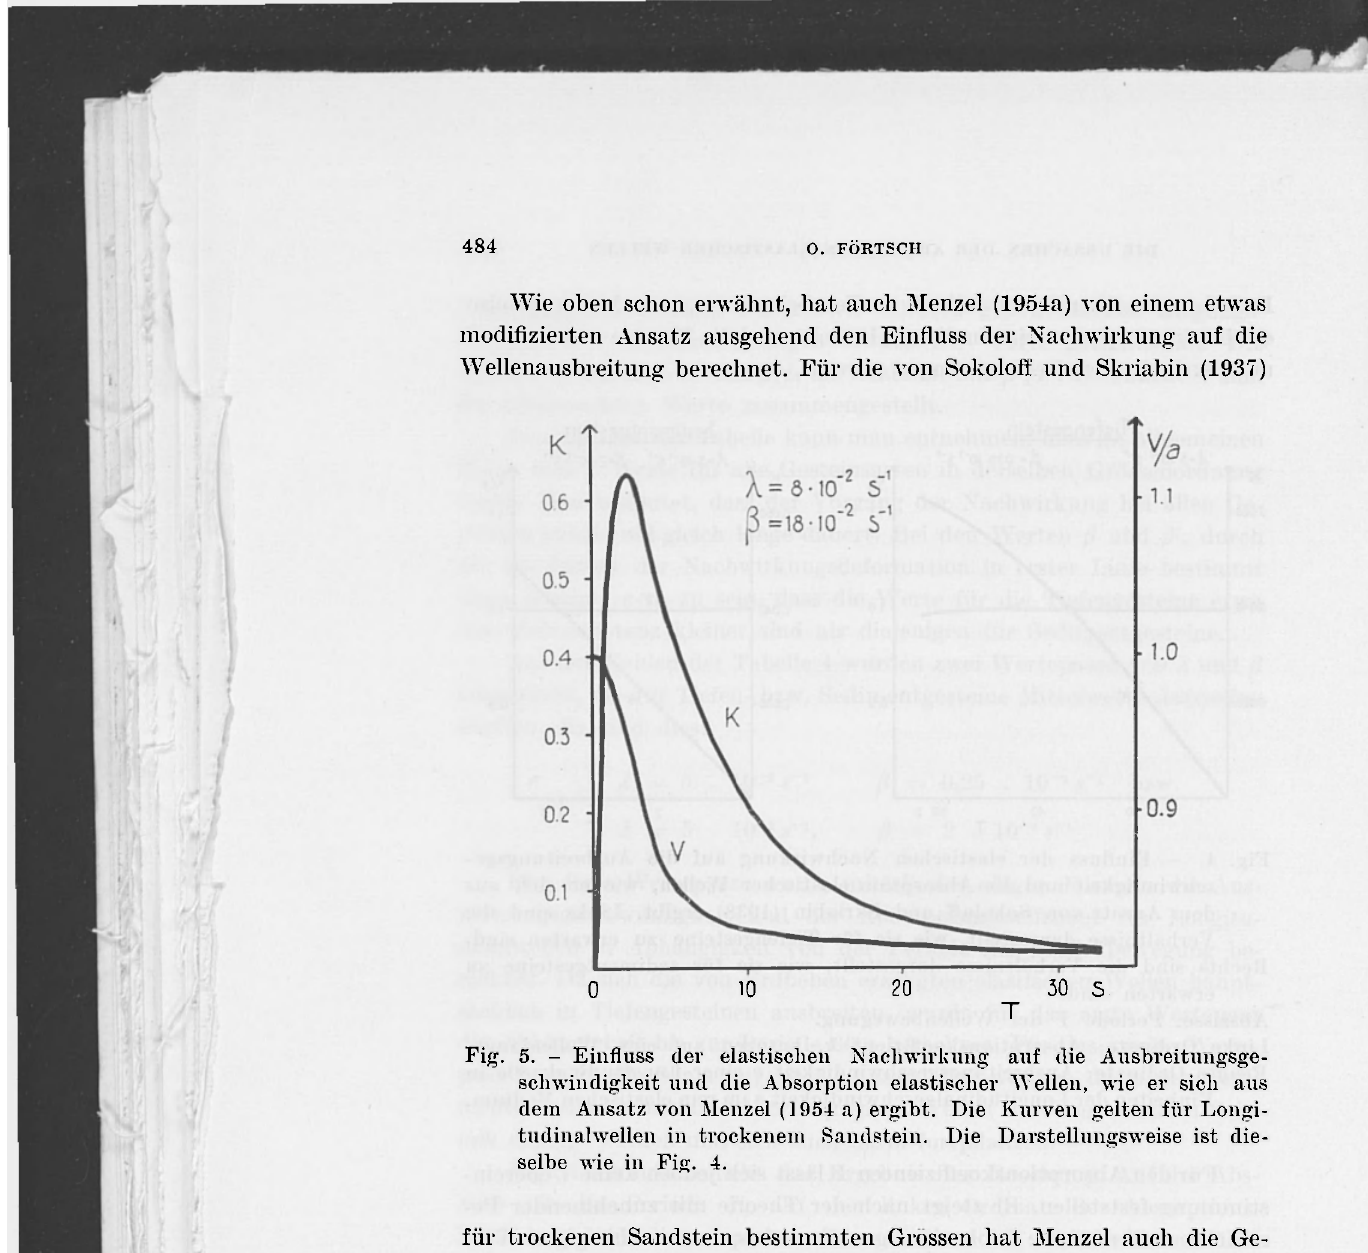
Fig. 5. - Einfluss cler elastischen Nachwirkung auf die Ausbreitungsge- schwindigkeit und die Absorption elastiseher Wellen, wie er sich aus dem Ansatz von Menzel (1954 a) ergibt. Die Kurven gelten fiir Longi- tudinalwellen in trockenem Sandstein. Die Darstellungsweise ist die- selbe wie in Fig.